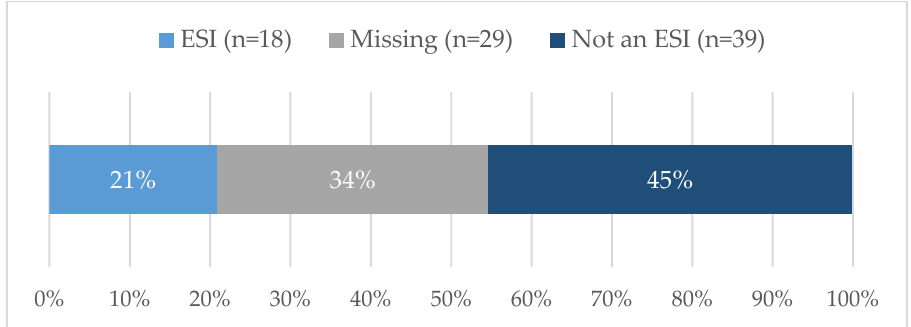
Figure 2. ESI TAG-SC user rates during Phase II: Pilot Year and Phase III: Year 1 of TAG-SC (N = 86).